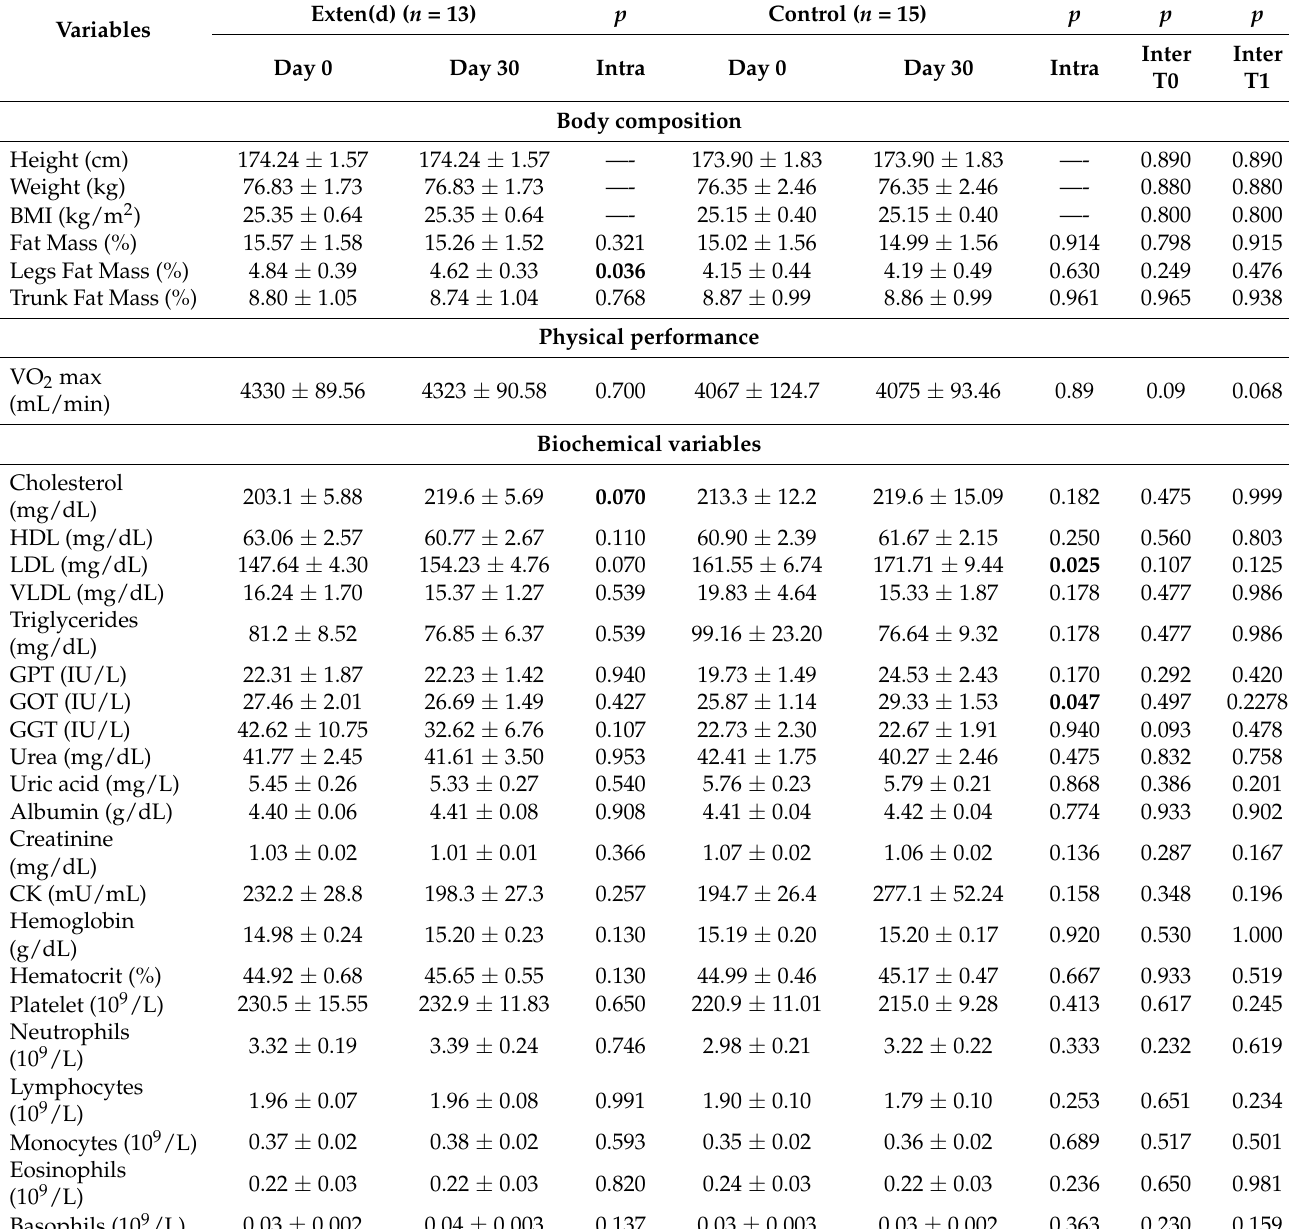
Table 1. Changes in body composition, maximal oxygen consumption and biochemical variables after administration of 2 g of Exten(d) for 30 days compared to